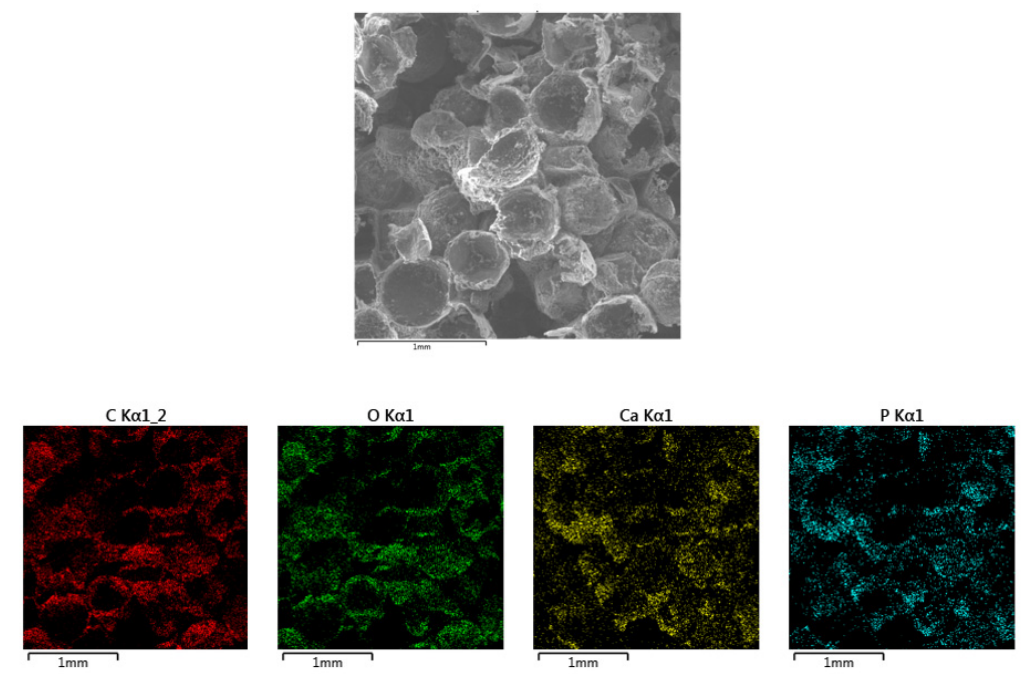
Figure 2. Elemental analysis and distribution of carbon, oxygen, calcium, and phosphorus in the sample.